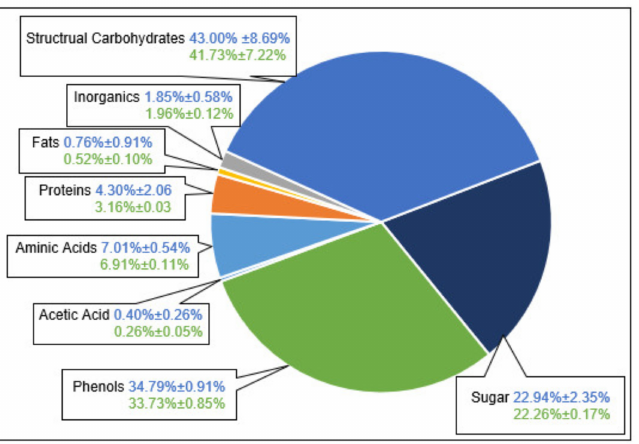
Figure 14. Composition of bearberry leaf extract determined by offline analytics (green) and presented FTIR spectra